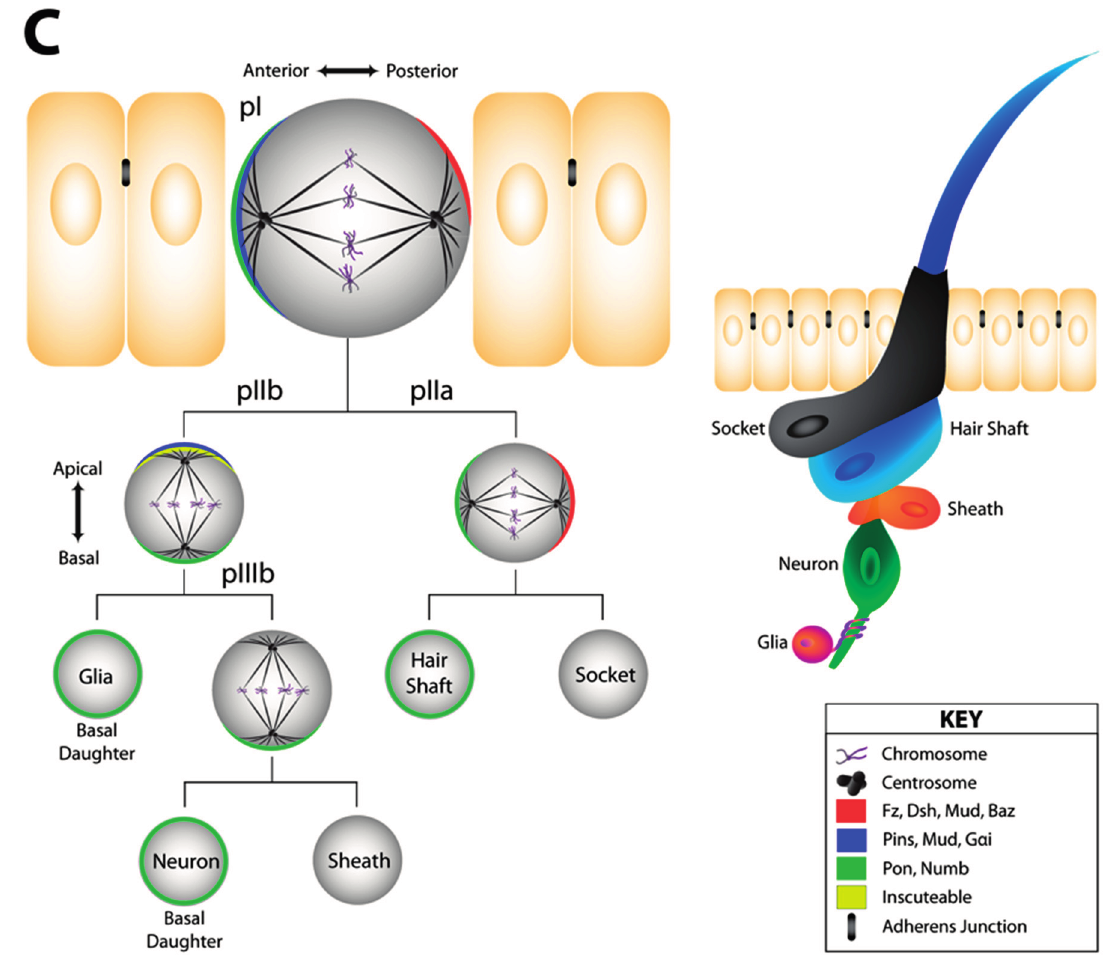
Figure 2. Oriented cell division in Drosophila . ( A ) Neuroblasts delaminate from the neuroepithelium and establish and apical-basal cortical polarity. The stemness-promoting aPKC enzyme (red) is apically localized and functions to restrict differentiation complexes (green) to the basal cortex. Spindle orientation along this polarity axis is achieved through the function of the apical Pins/Mud/Dlg complex (blue). In addition to asymmetric protein distribution, centrosomes are asymmetrically inherited in daughter cells with the daughter and mother centrosome preferentially segregated in the self-renewed neuroblast and differentiating ganglion mother cell (GMC), respectively; ( B ) Neuroblast divisions must properly balance self-renewal with differentiation: GMC daughters generate neurons and glial cells that integrate into the functioning central nervous system, whereas the neuroblast pool remains relatively constant throughout development. gcm ( glial cells missing ) is a gene that is known to regulate glial cell fate in Drosophila. If gcm is upregulated in a GMC daughter cell, it will differentiate into a glial cell [28,29]; ( C ) Sensory organ precursors (SOPs) produce mechanosensory organs within the developing wing. The initial pI cell polarizes along an anterior-posterior axis and uses two distinct spindle positioning pathways, anterior Pins/Mud and posterior Fz/Dsh, to asymmetrically distribute Numb to the anterior pIIb daughter. Further rounds of oriented divisions, including an Insc-mediated apical-basal division of the pIIb, results in the mature mechanosensory organ structure consisting of five distinct cell fates that function in concert within the adult wing